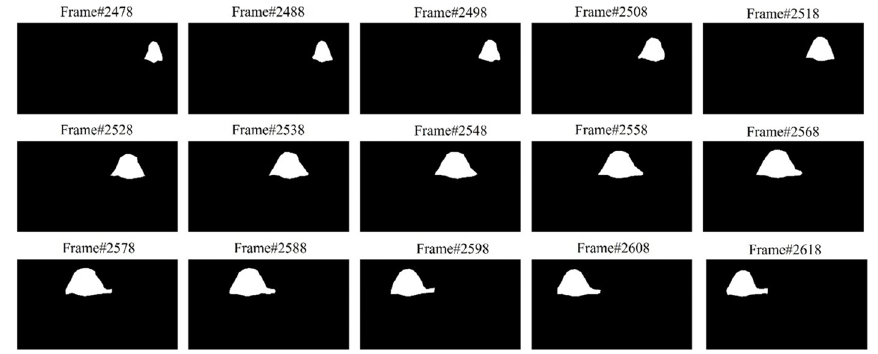
Fig. 9 Ground truth (GT) masks of the axle l in the dataset